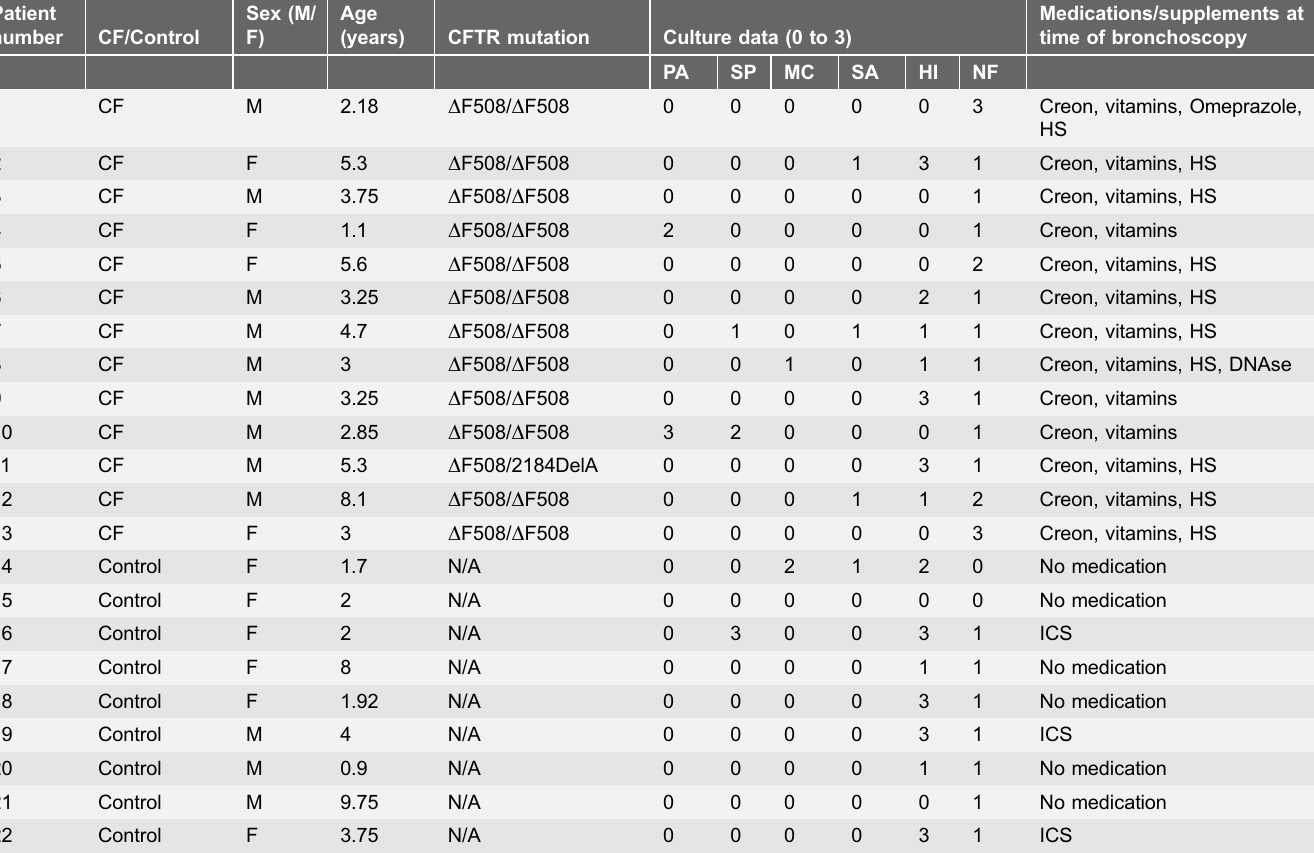
Table 1. Baseline demographic and clinical characteristics of all patients included in the